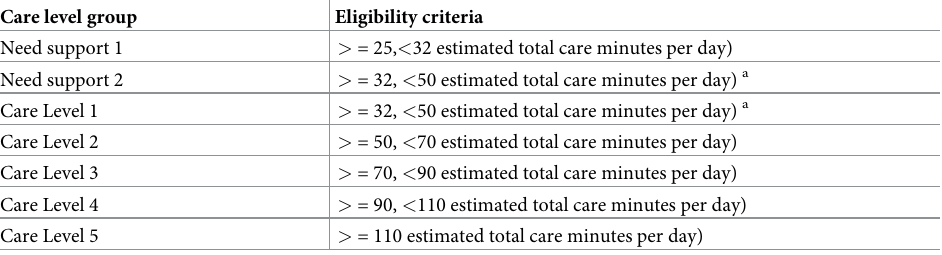
Table 1. Long-term care insurance (LTCI) care needs levels of